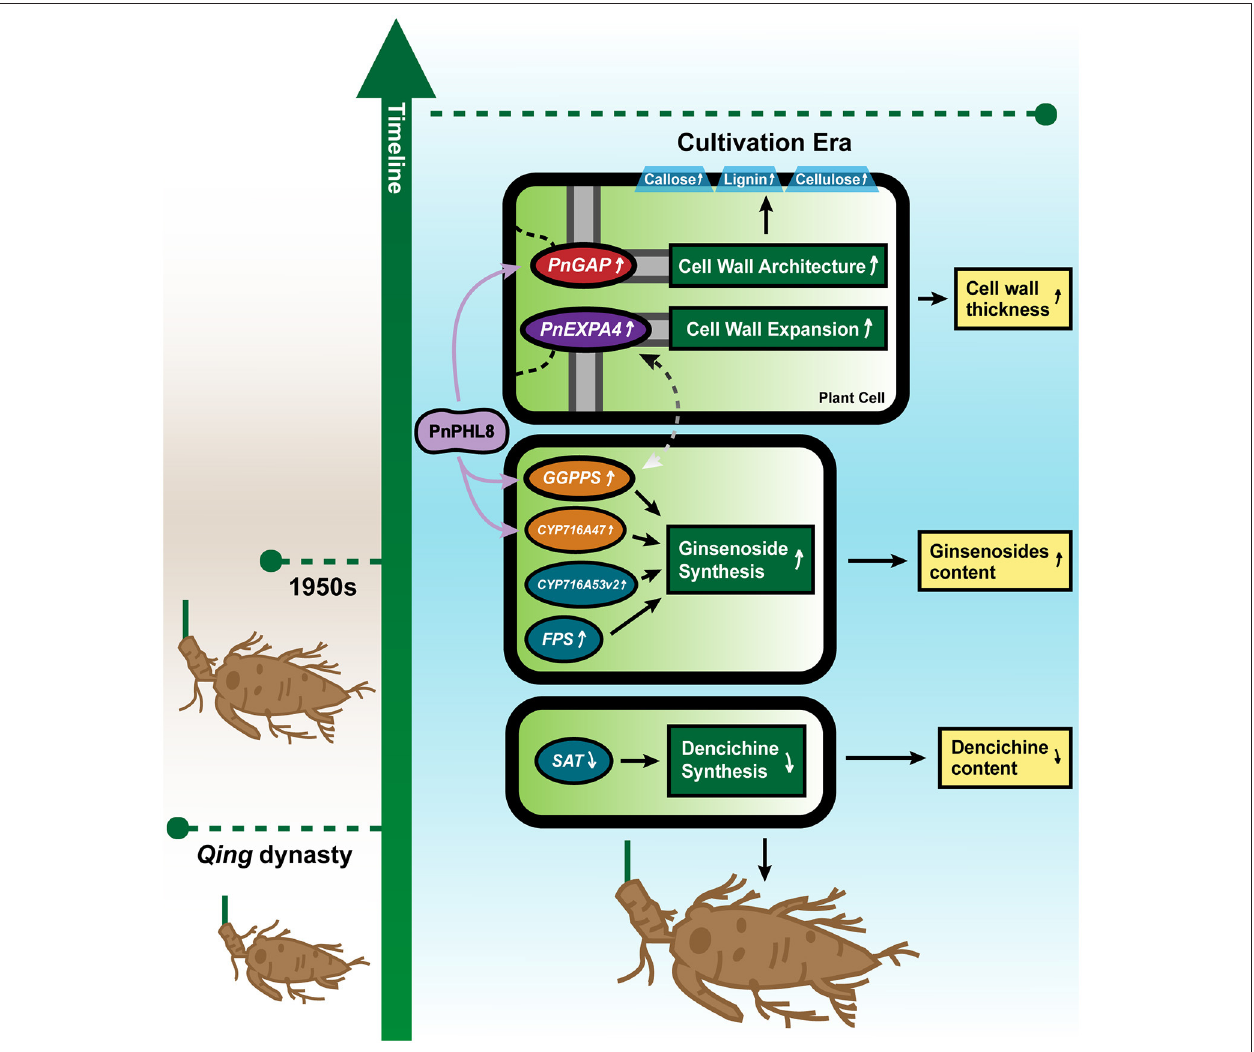
FIGURE 6 | Probable molecular mechanism model for cultivation influencing root architecture and chemical component of P. notoginseng. Changes in root size and active component accumulation of P. notoginseng are influenced by related genes and affected by changes in the cultivation environment. Increased expression of PnGAP and PnEXPA4 results in the thicker cell wall and a higher content of lignin, cellulose, and callose in P. notoginseng of cultivation era. Higher expression of GGPPS , FPS , CYP716A47, and CYP716A53v2 contributes to a higher content of ginsenosides, while lower expression of SAT might result in a lower content of dencichine. A PnPHL8 transcriptional factor participates in transcriptional regulation of PnGAP , PnCYP716A47, and PnGGPPS3 , while dotted line between PnEXPA4 and PnGGPPS3 indicates that a probable positive correlation may